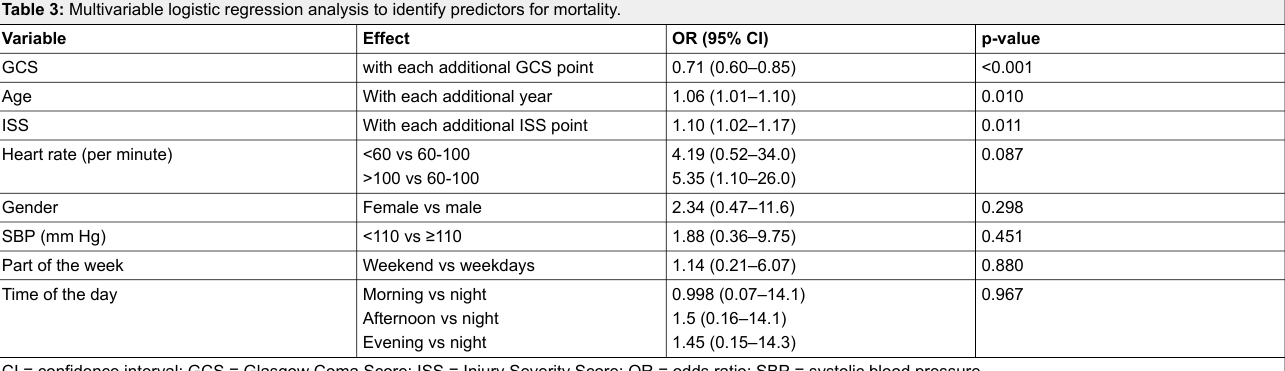
Table 3: Multivariable logistic regression analysis to identify predictors for